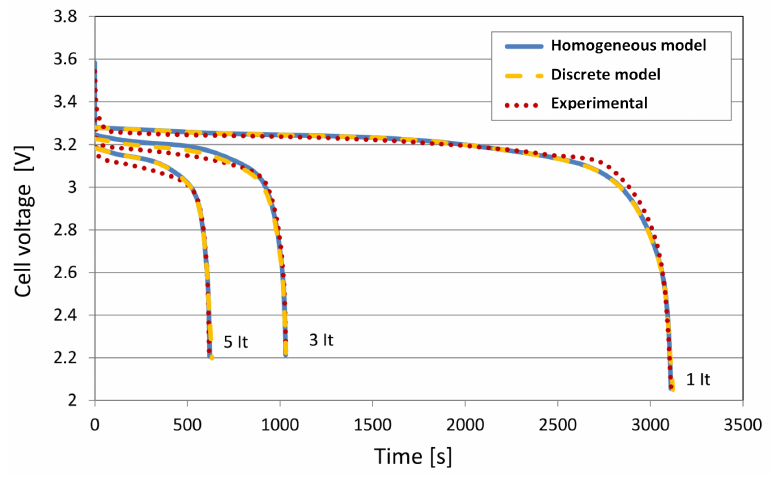
Figure 4. Voltage evolution during constant current